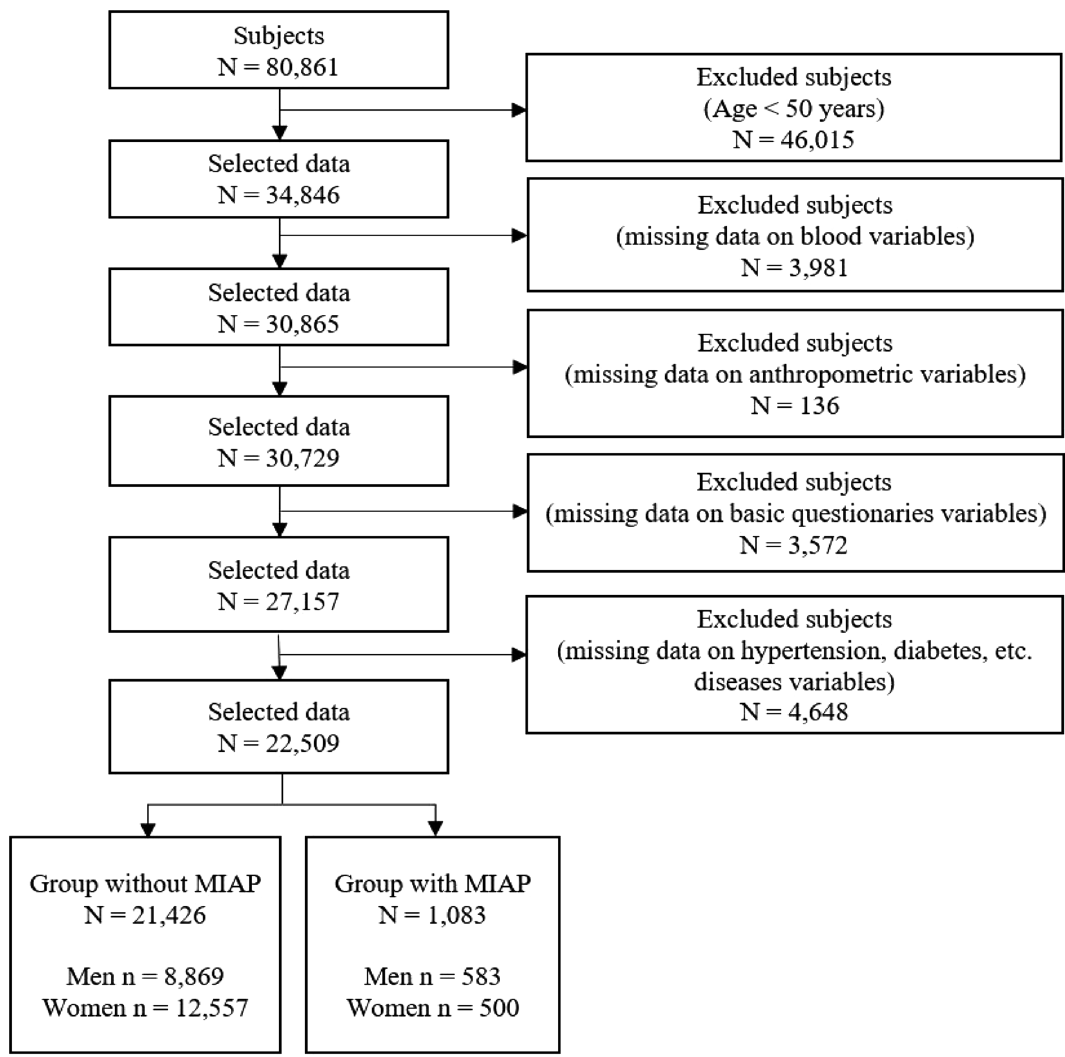
Figure 1. Sample selection procedure. MIAP myocardial infarction or angina